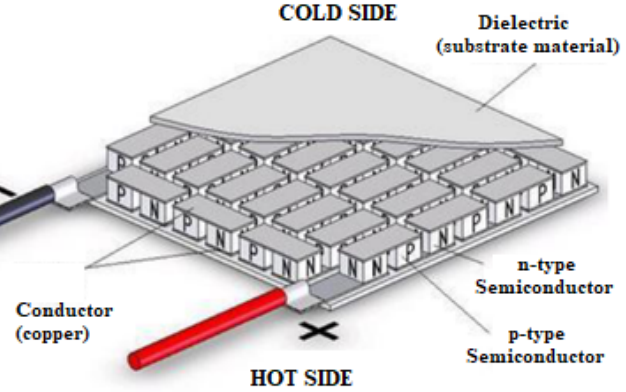
Figure 2. Thermoelectric generator [15].